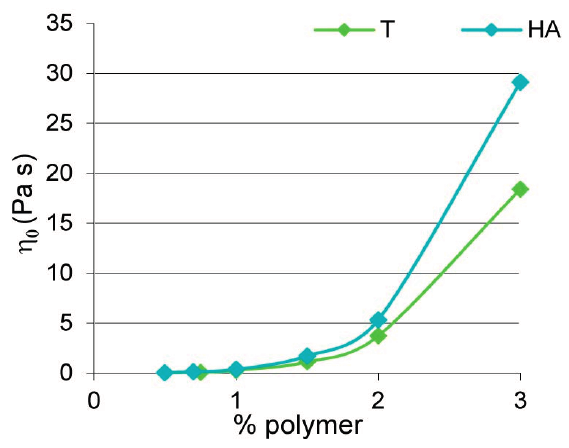
Figure 3. Viscosity at rest ( η 0 ) values as a function of polymer concentration.